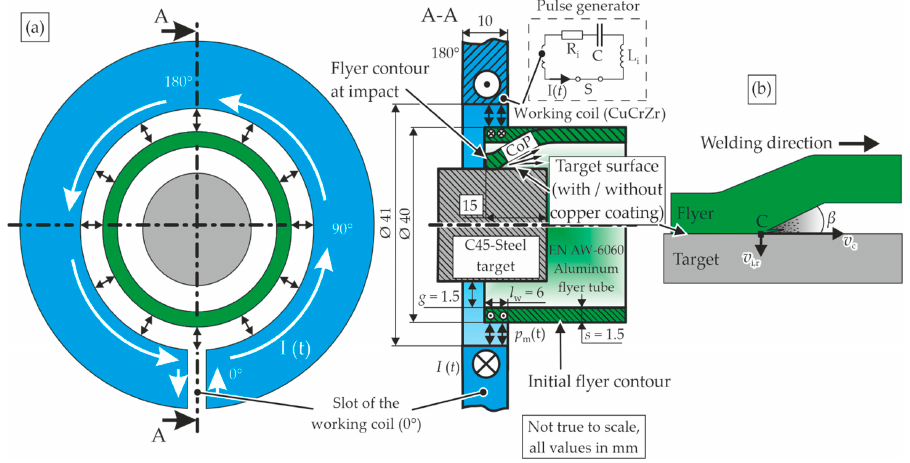
Figure 1. ( a ) Schematic of the MPW setup and ( b ) velocity components at the collision point C. Table 2. Characteristics of the RLC-circuits and the deployed pulse generator. Setup Unit